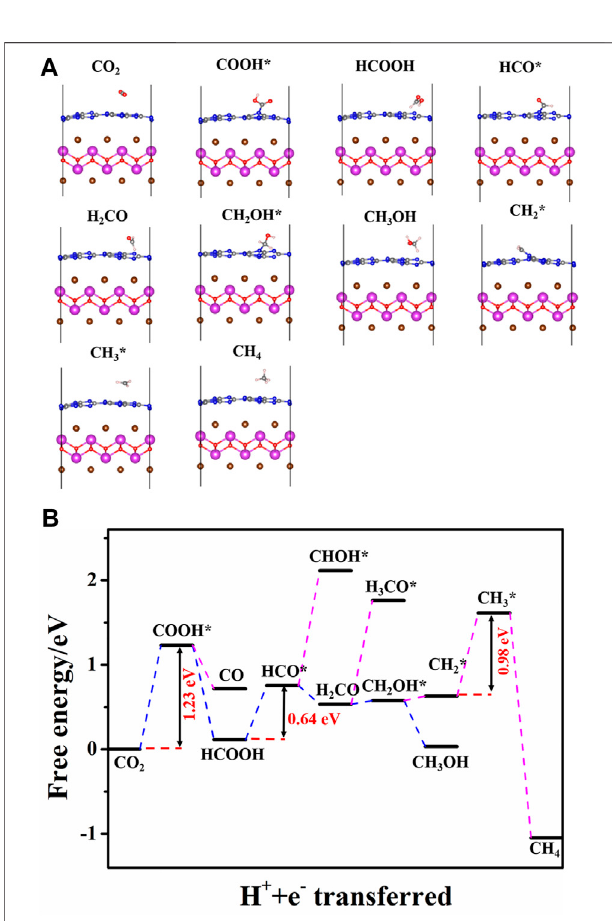
FIGURE 9 | (A) Optimized structure of reaction intermediates and (B) free energy diagram on the optimal path of CO 2 reduction on BiOBr/g-C 3 N 4 . The blue and red dotted lines indicate optimal and infeasible reaction paths, respectively. The white spheres represent H atoms.